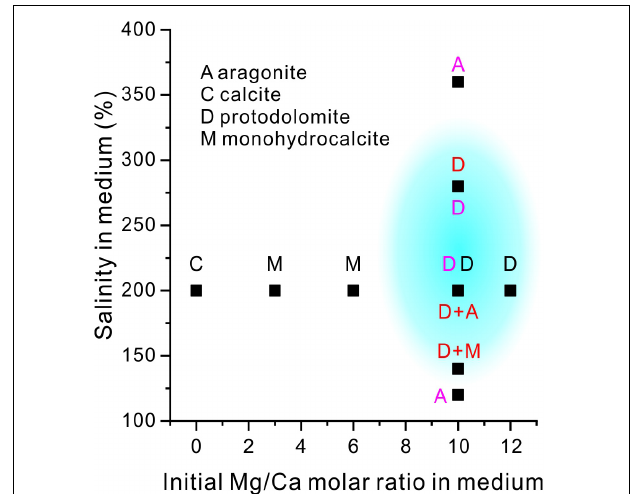
FIGURE 14 | The relationship between the d 104 values and the MgCO 3 volume in the magnesium calcite isomorphism series from this and previous FIGURE 15 | A comparison of the present experiment results with previous studies. The straight dashed line is the linear function studies of mineralogy with salinity and increasing Mg/Ca ratios. The blue = B-M × d 104 , where N MgCO (N MgCO is the molar percentage of MgCO 3 3 3 shadow shows the possible formation conditions of the extreme halophilic in the isomorphisms, d104 is the observed (104) interplanar spacing (Å), bacterially-induced protodolomite. Letters in a black, red and purple color are B = 1011.99, M = 333.33). the results of the present study, the results of Qiu et al. (2017) and the results of Qiu et al. (2019),